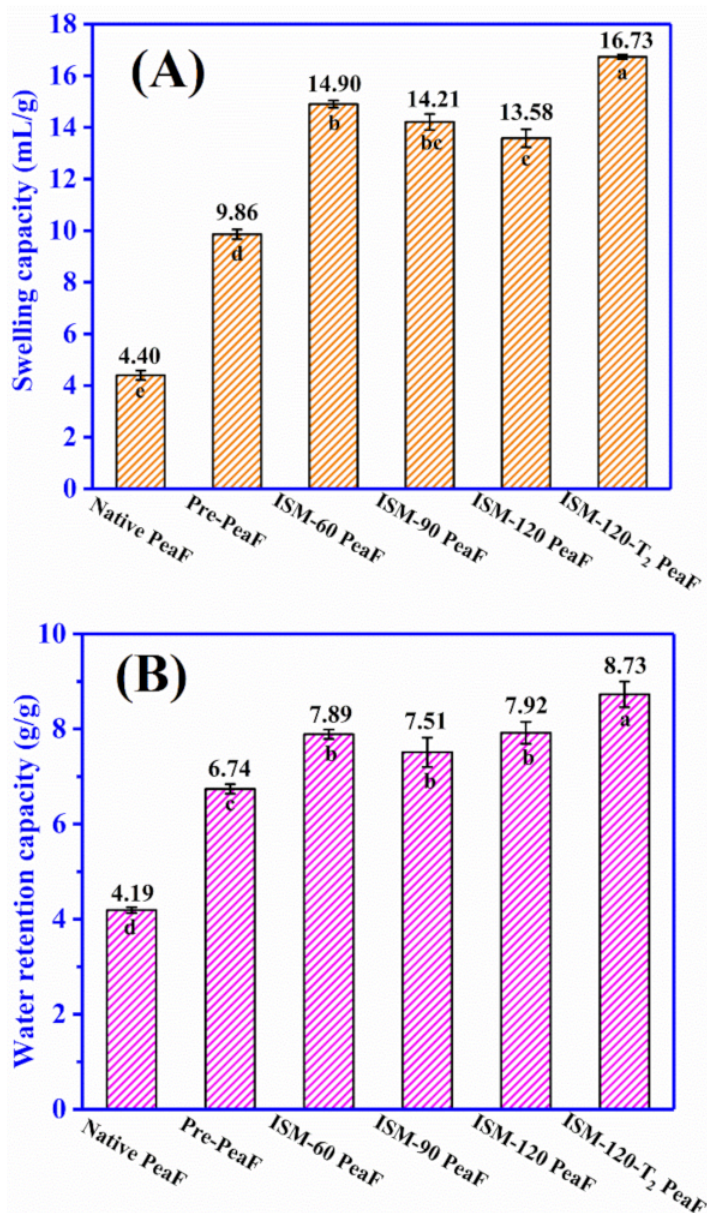
Figure 6. Swelling capacity ( A ) and water retention capacity ( B ) of ISMS-treated PeaF. Different letters in ( A , B ) indicated significant differences ( p < 0.05) of hydration properties between